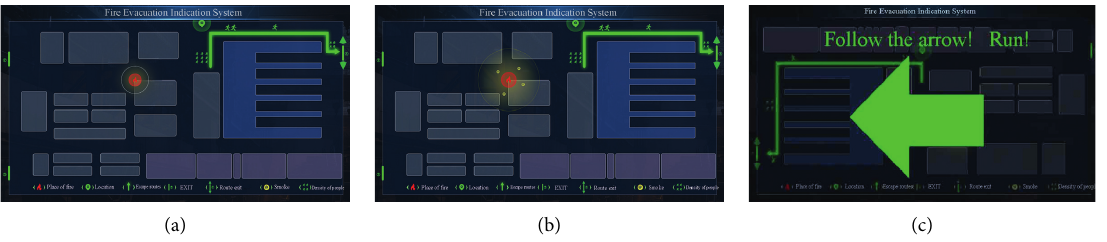
Figure 9: Indication presented in the interface; (a) small smoke concentration; (b) dense smoke; (c) arrows indicating the escape routes.